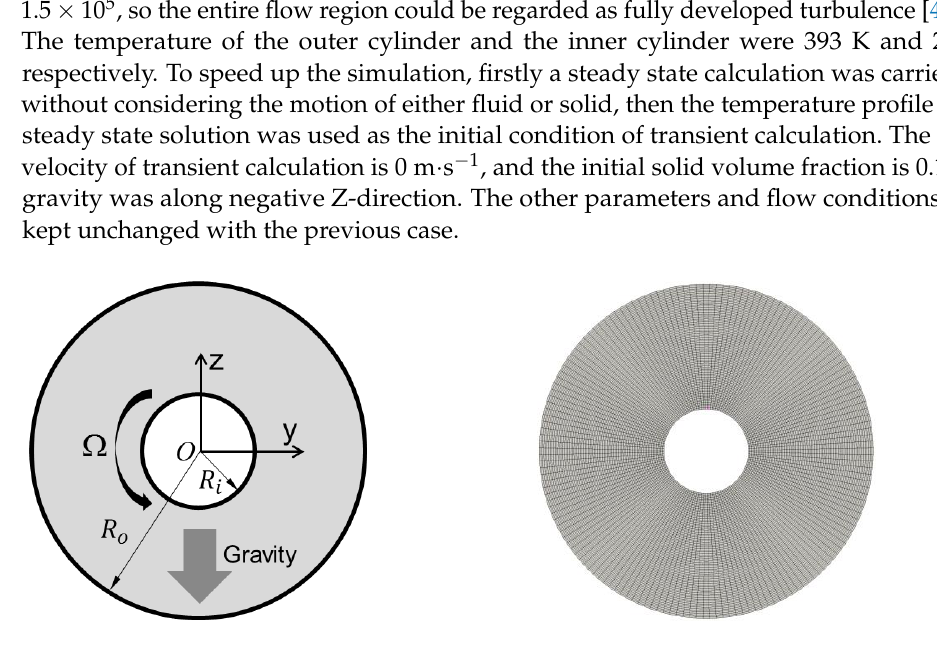
Figure 6. Geometry and computational grid of the two concentric cylinders.